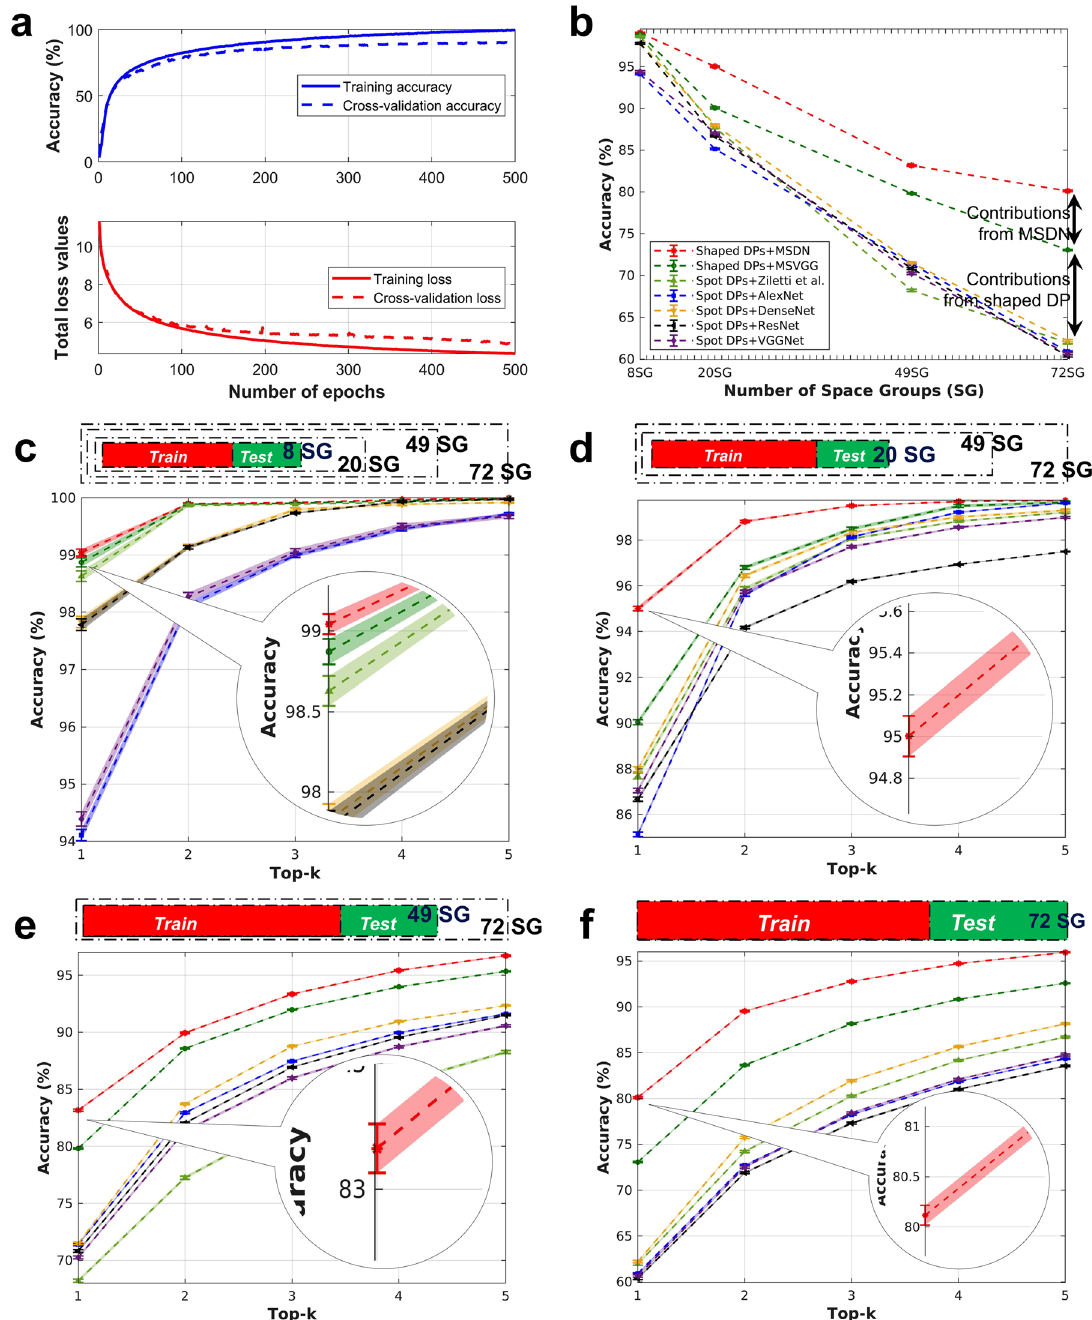
Fig. 3 Space group classi fi cation performance. a The learning process of MSDN using 72 SG dataset. The classi fi cation accuracy and total loss is shown both in training and cross-validation phases. b Top-1 accuracy as a function of the number of space groups for classi fi cation with standard deviation. c – f Top- k accuracies for the datasets consisting of 8 SGs ( c ), 20 SGs ( d ), 49 SGs ( e ), and 72 SGs ( f ). The top- k accuracy refers to the percentage of cases in which the correct class label appears among the top- k probabilities. The circled insets magnify the results of the “ shaped DPs + MSDN ” model for a clearer vision of error